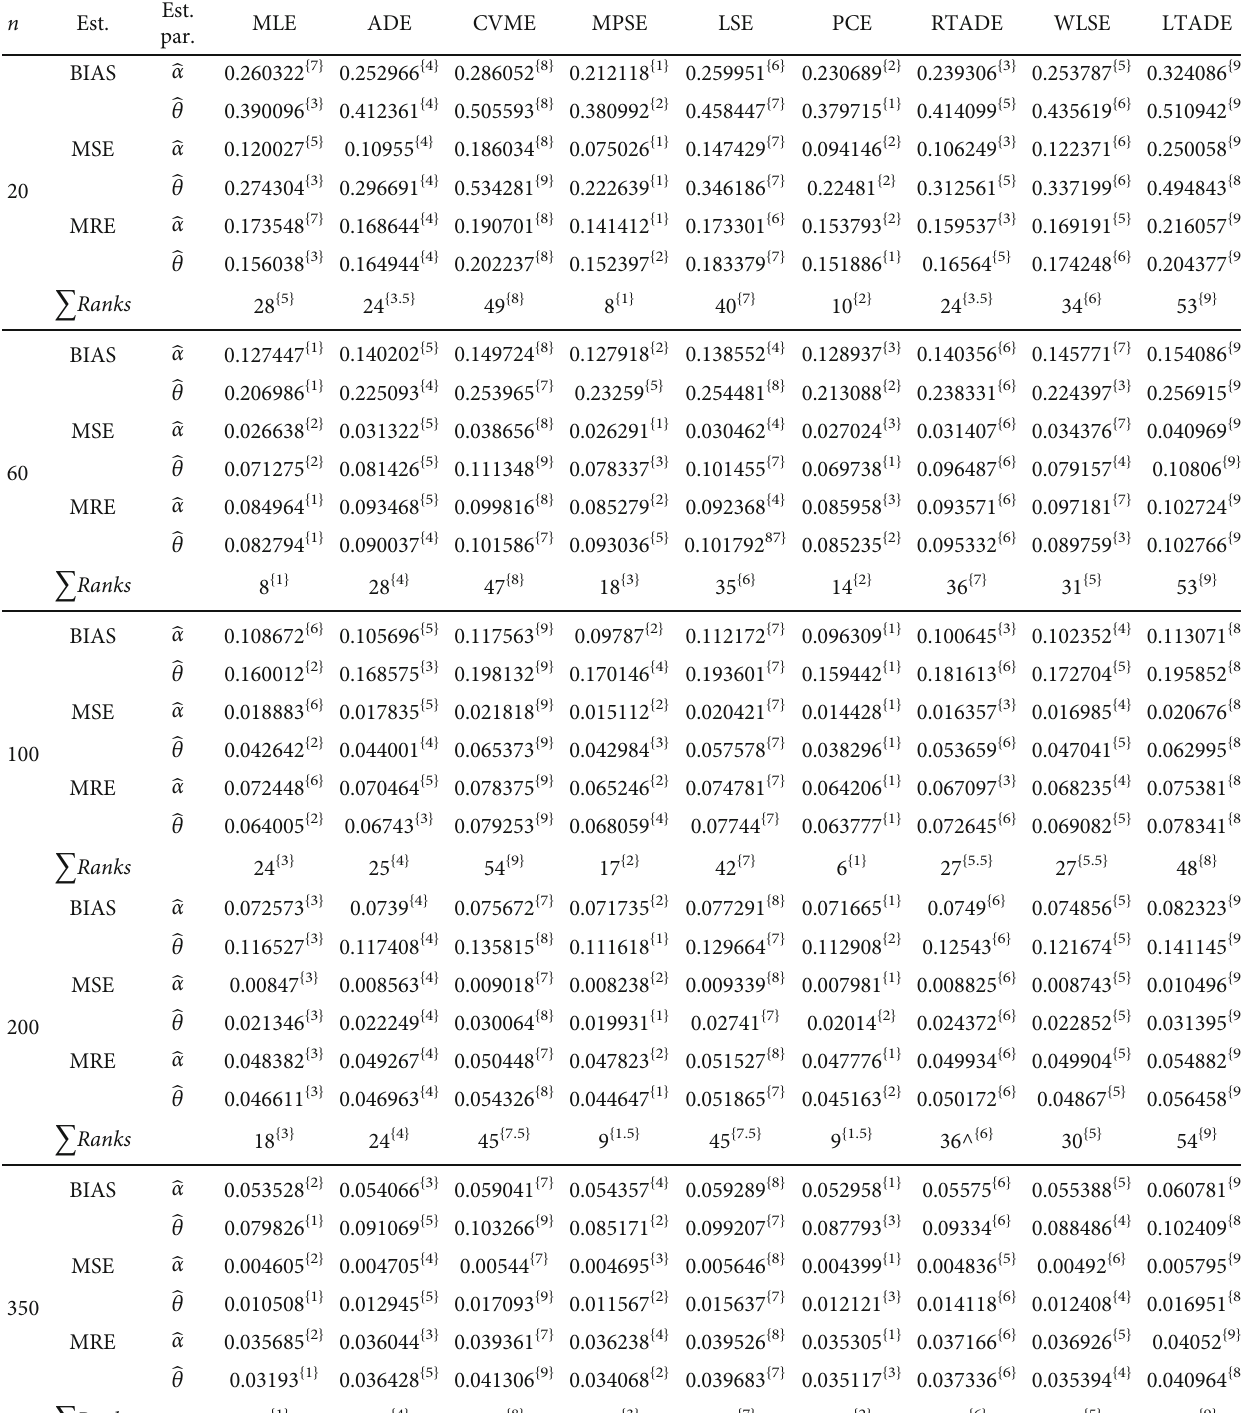
Table 5: Simulation values of BIAS, MSE, and MRE for α = 1 : 5 and θ = 2 : 5